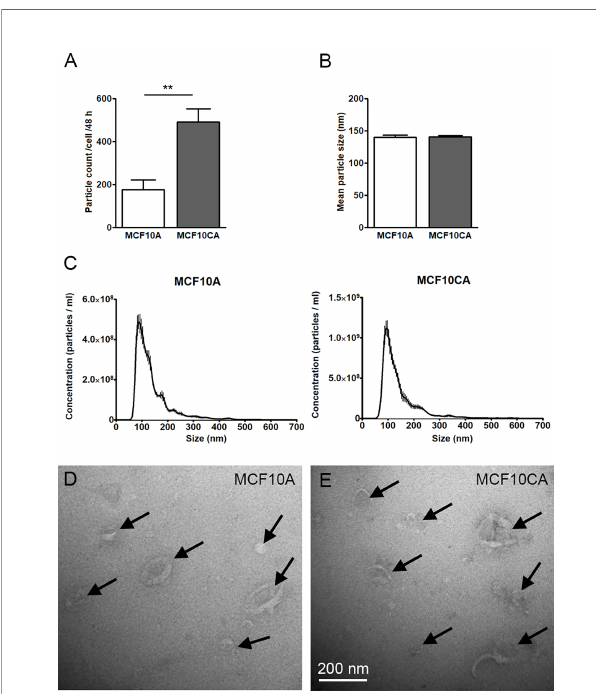
FIGURE 2 | MCF10CA cell produce more EVs than MCF10A cells. Particle counts (A) , mean particle sizes (B) and size distributions (C) of EV isolates from MCF10 cell lines analyzed by NTA. TEM images from the same isolates are shown in (D, E) . The data represent means ± SE of 5-6 independent experiments in (A, B) and means ± SE of 5-6 independent experiments in (C) **p < 0.01, Mann – Whitney test. Arrows point EVs in panels (D, E) .